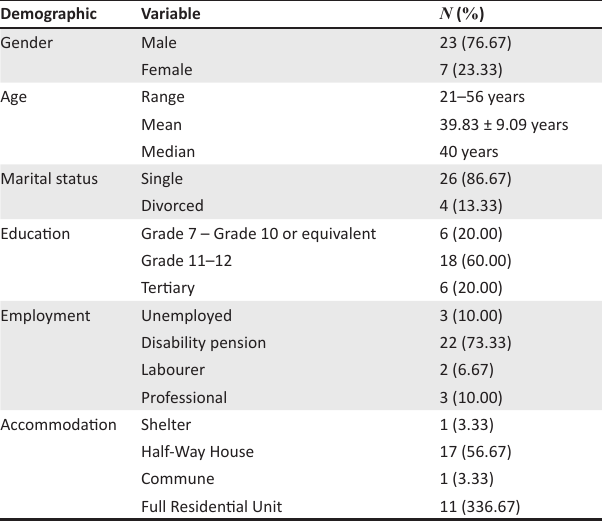
TABLE 1: Demographic data ( n = 30).